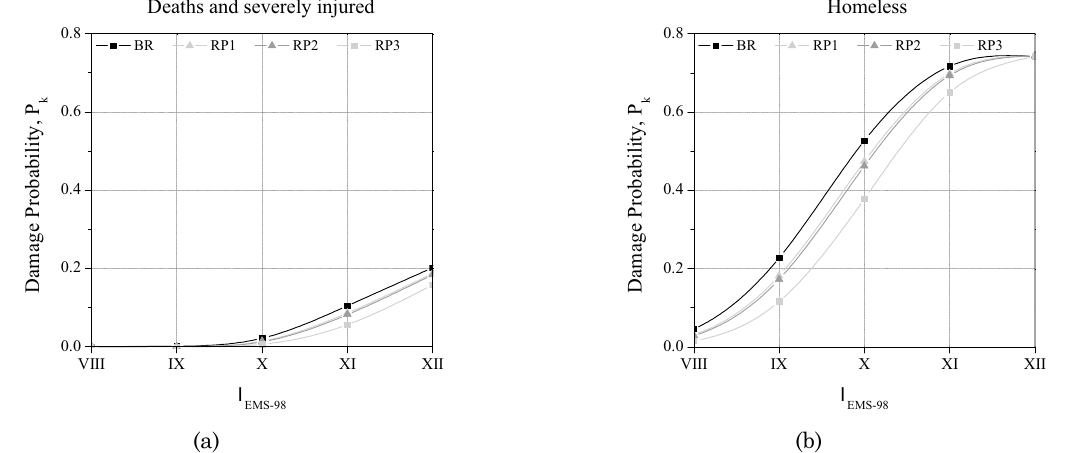
fig. 5. Probability of deaths and severely injured (a) and homeless (b) for the evaluated building conditions (Br to